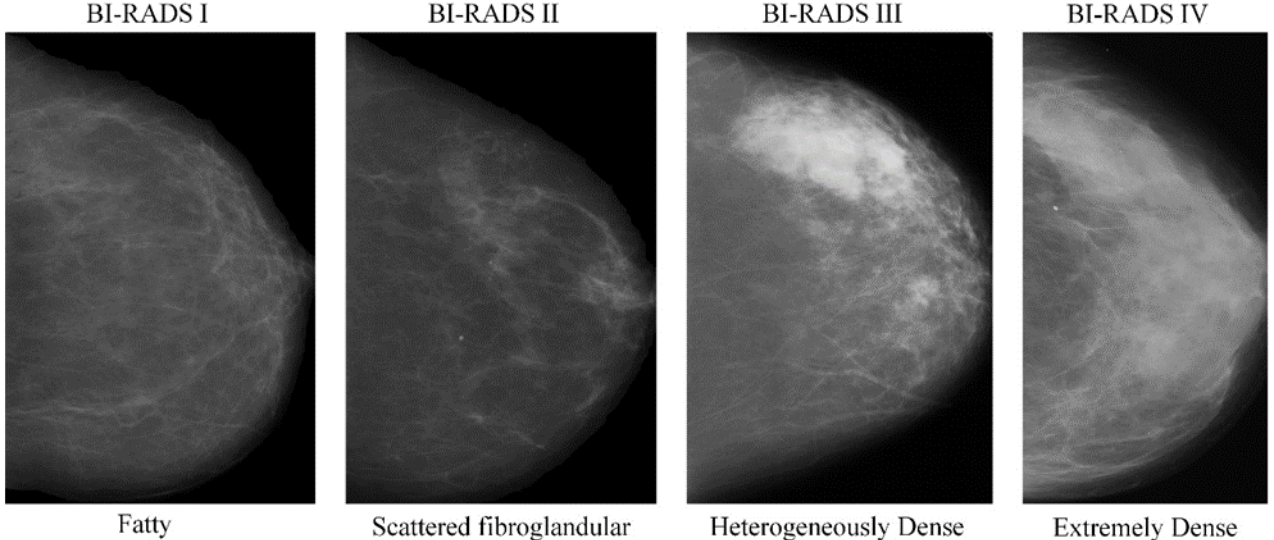
Figure 1. Examples of BI-RADS breast composition categories of breast density in increasing order of density from left to right [11].